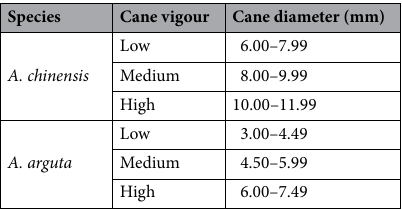
Table 1. Distribution of canes by their